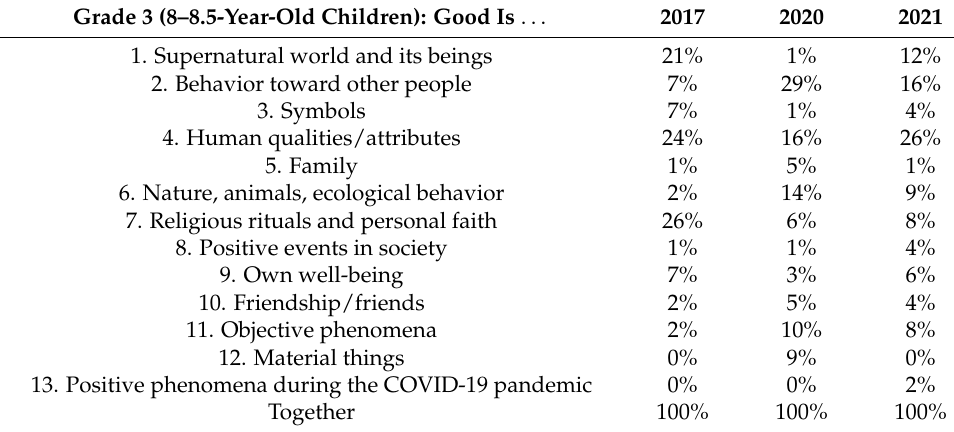
Table 4. The concept of good by 8–8.5-year-old children (Grade 3). Grade 3 (8–8.5-Year-Old Children): Good Is . .